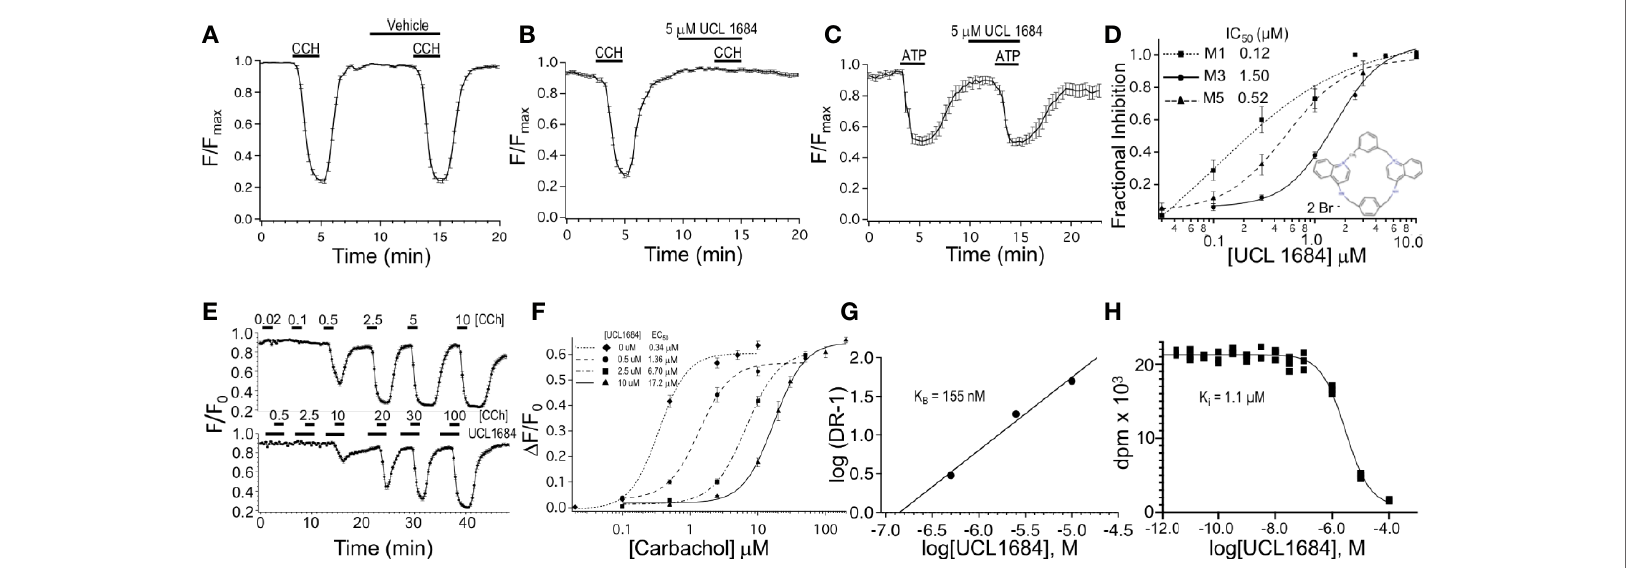
FIGURE 1 | UCL 1684 is an antagonists for muscarinic acetylcholine receptors, but not purinergic receptors. (A) R-CEPIAer response to repeated 0.5 m M carbachol administration before and after vehicle (0.1% DMSO). R-CEPIAer fl uorescence is normalized to maximal fl uorescence (F/F max ). Data is plotted for mean ± standard error of the mean. Fractional inhibition of second CCH response with vehicle was 0.0004 ± 0.018 of fi rst response for N = 30 cells. (B) Same as in A except that 5 m M of UCL 1684 was applied preceding and during the second 0.5 m M carbachol administration. Fractional inhibition by UCL 1684 was 0.99 ± 0.011 for N = 30 cells. (C) R-CEPIAer response to repeated 1 m M ATP administration to CHO cells co-transfected with the human P2Y1 purinergic receptor. The second ATP administration included 5 m M UCL 1684. Fractional inhibition by UCL 1684 was 0.067 ± 0.06 for N = 20 cells. (D) R-CEPIAer dose-response to 0.5 m M CCH with increasing doses of UCL 1684. Data is plotted as mean fractional inhibition of 0.5 m M CCH response as a function of UCL 1684 concentrations. Inset is the molecular structure of UCL 1684 (from (Campos Rosa et al., 1996). Fitting of the inhibition curves to a Hill equation indicated IC 50 and slope values of the following: M1 receptor 0.12 ± 0.18 m M, slope 0.67 ± 0.5, N=55 – 61; M3 receptor 1.5 ± 0.14 m M, slope 1.8 ± 0.29, N=28 – 30; M5 receptor 0.52 ± 0.05 m M, slope 1.4 ± 0.17, N=58. (E) R-CEPIAer response in M3 mACHR expressing cells to increasing carbachol administration in the absence (above) and presence (below) of 10 m M UCL 1684. Data is plotted as mean ± s.e.m. for N =19 for control, and N=21 for 10 m M UCL 1684. (F) D F/F 0 R-CEPIAer response M3 mACHR expressing cells as in (E), were plotted for increasing carbachol concentrations alone (diamond, EC 50 0.34 ± 0.06, slope 2.0 ± 0.65, N=19), or carbachol with UCL1684: 0.5 m M (circle, EC 50 1.36 ± 0.26, slope 1.9 ± 0.45, N=20), 2.5 m M (square, EC 50 6.70 ± 0.47, slope 1.8 ± 0.18, N=20) and 10 m M (triangle, EC 50 17.2 ± 0.90, slope 1.9 ± 0.20, N=21). (G) Schild analysis of M3 receptor inhibition by UCL1684. EC 50 values from F were used to plot log of Dose Ratio -1, (DR, carbachol EC 50 value in the presence/EC 50 absence of UCL1684) as a function of log of UCL1684 concentration. Linear regression fi tting yielded a slope of 0.94, y-intercept of 6.4, and a theoretical X-intercept yielding a pKi of 6.8 ( K i of 155 nM). (H) A representative binding experiment using M3 mACHR-expressing CHO cell membranes (25 ug) incubated with 0.9 nM [ 3 H]-NMS and indicated concentrations of UCL1684 (as described in Methods). The experiment shown indicated a pKi of 5.95 (Ki 1.1 m M). The average pKi was 6.04 ± 0.04 (909 nM, Mean ± SEM, n=3 separate